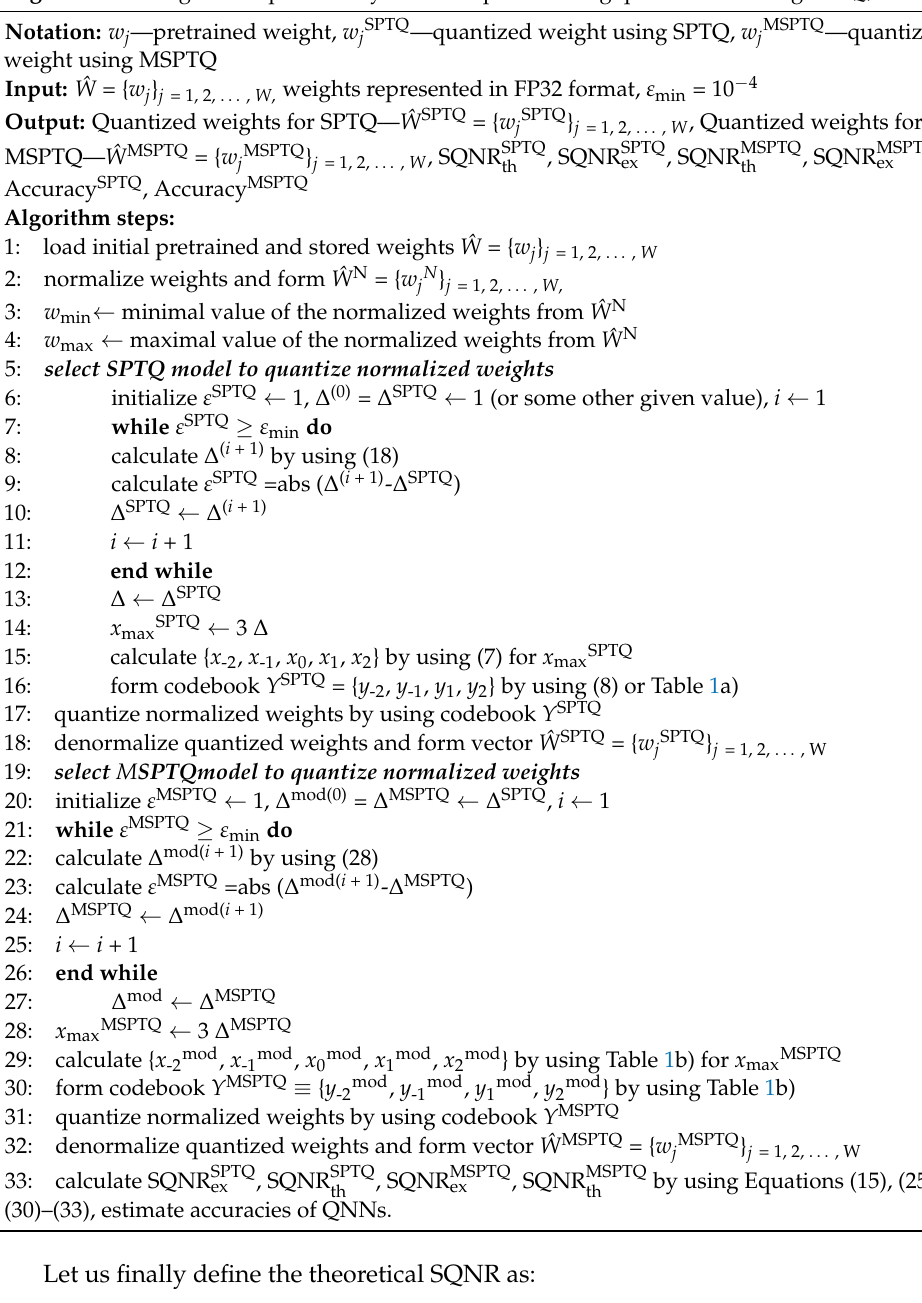
Algorithm 1 : Weights compression by means of post-training quantization using